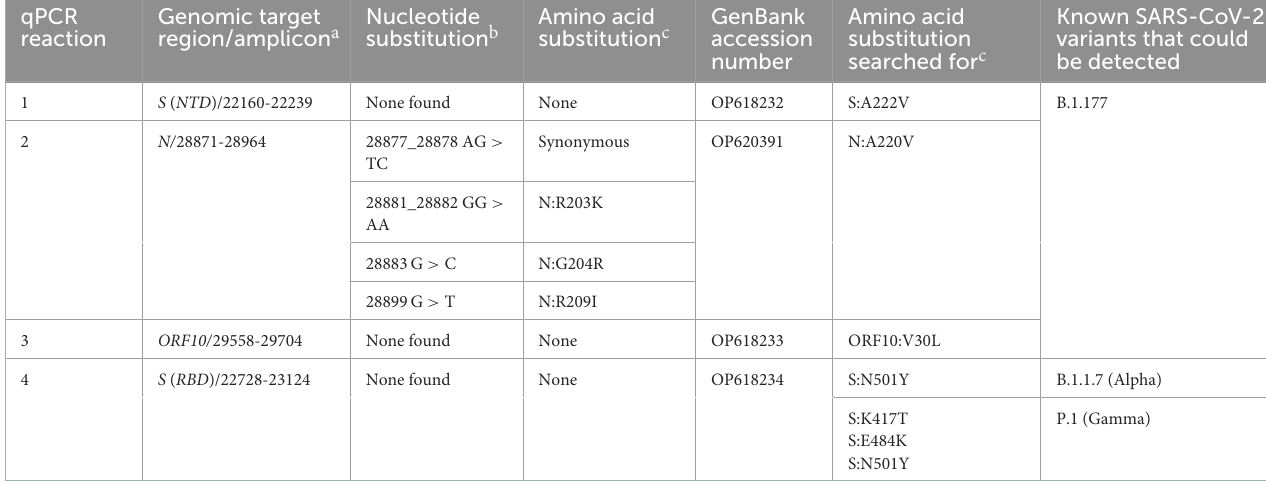
TABLE 1 Nucleotide and amino acid substitutions found after Sanger sequencing of the four PCR-amplified viral genomic regions.